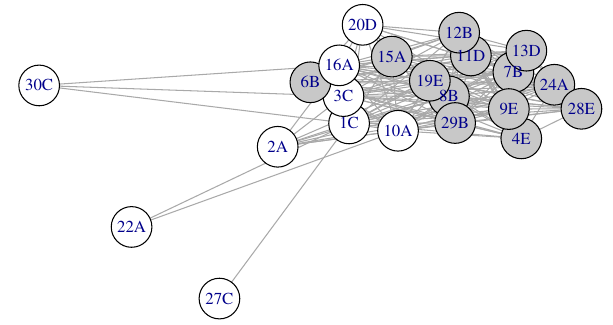
FIG. 3. Communities detected for the adjacency matrix of FCI post-test responses of women with an edge weight threshold of N= 2 using the fast-greedy